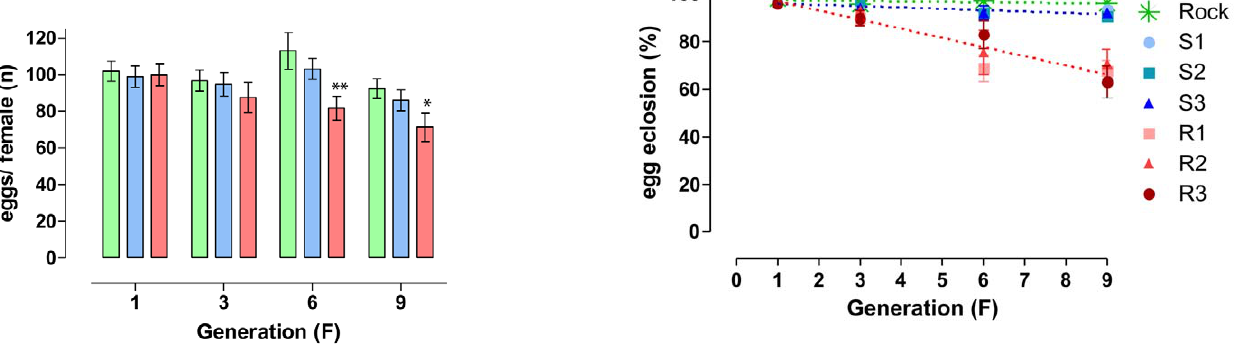
Figure 4. Number of eggs – selected lineages. Number of eggs per egglaying Aedes aegypti female during deltamethrin selection in the laboratory. Green, blue and red bars indicate respectively Rock, S and R females. Standard error is also indicated. Values significantly or highly significantly different from Rock are indicated by (*) or (**), respectively.